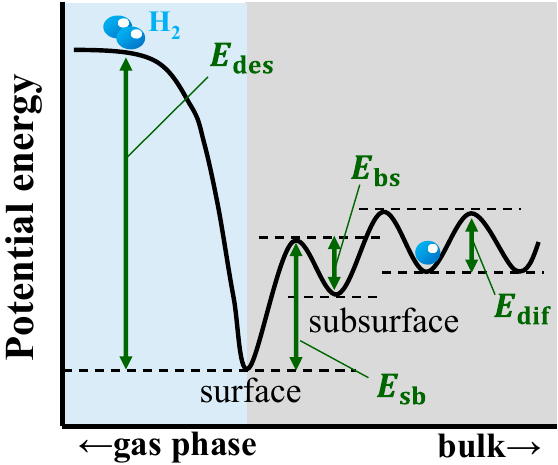
Figure 2. Schematic diagram of potential energy profile of hydrogen absorbing metals. E des , E sb , E bs , and E dif are the activation energy values for the desorption, migration of hydrogen from the surface to the subsurface and from the subsurface to the surface, and diffusion of hydrogen in the bulk region, respectively.